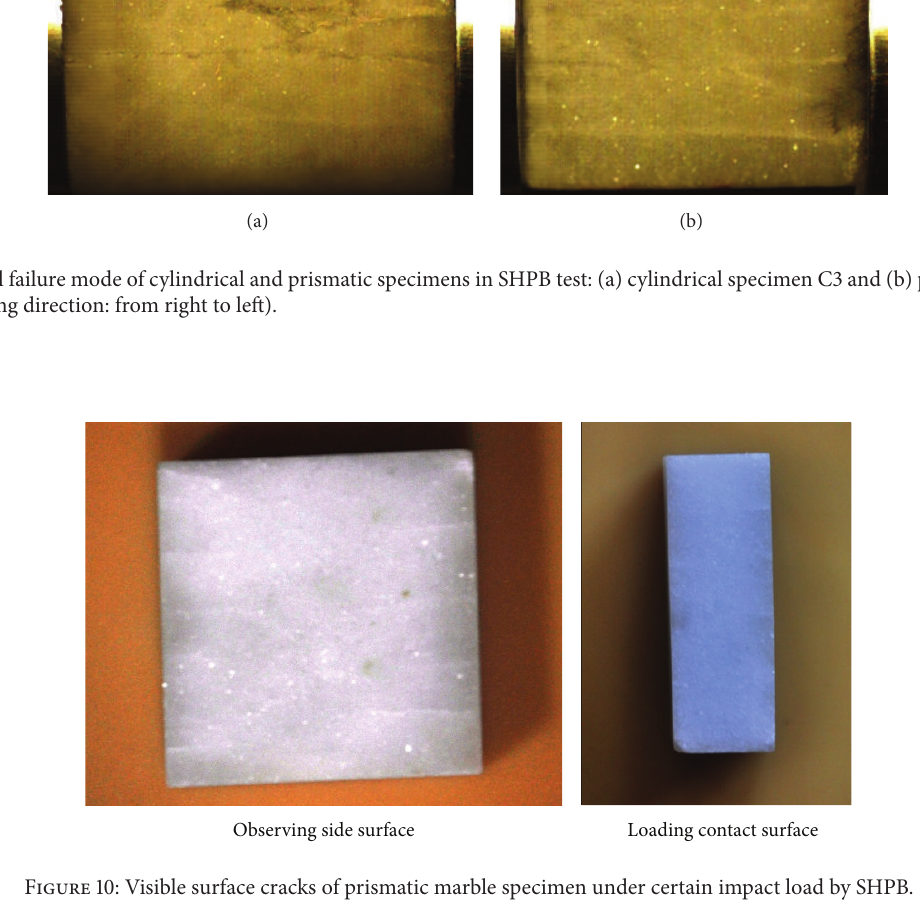
Figure 10: Visible surface cracks of prismatic marble specimen under certain impact load by SHPB.